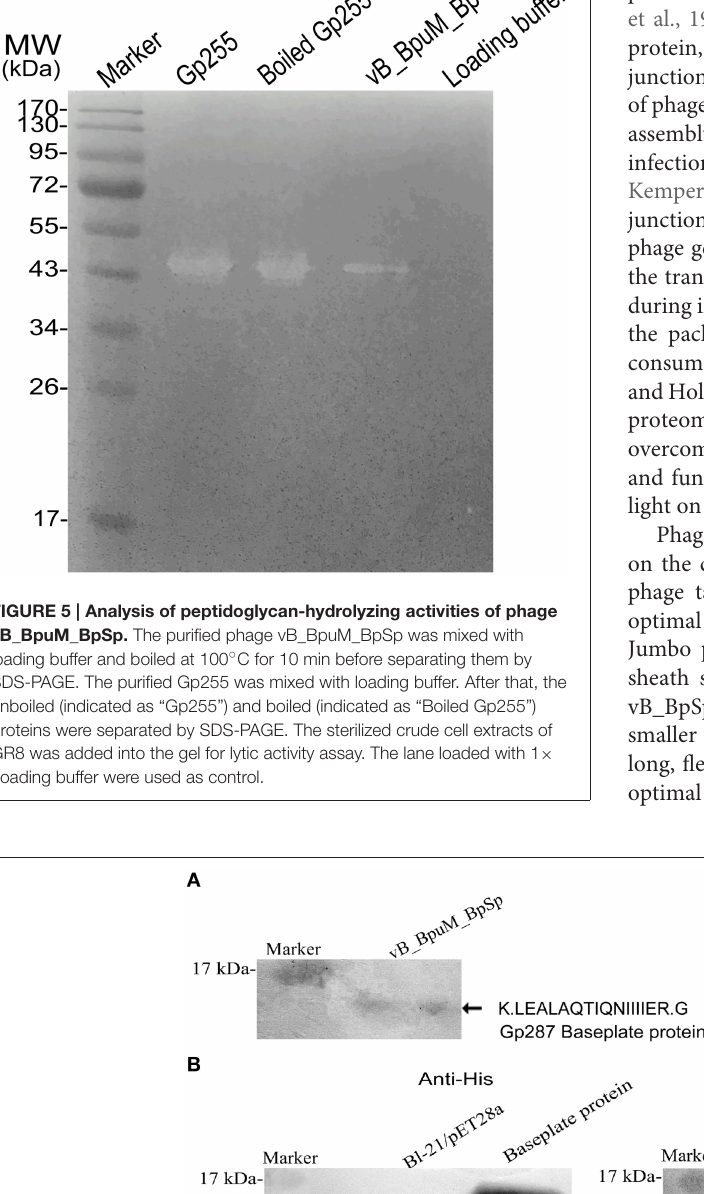
Frontiers in Microbiology |